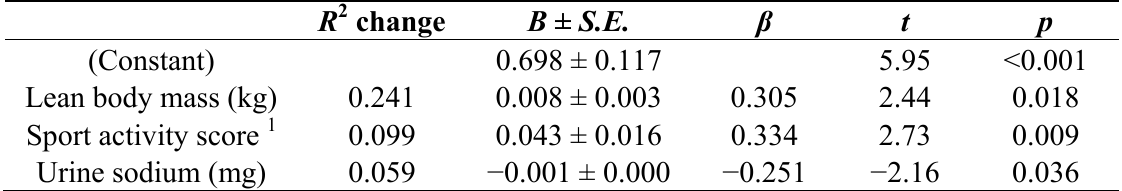
Table 3. Regression model for hip aBMD in women with calcium intake below the median ( n =